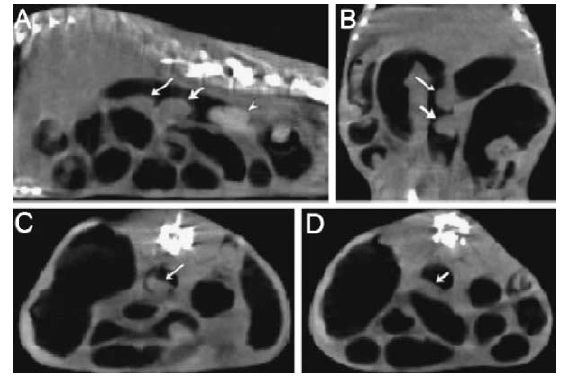
Fig. 1. Micro-CT colography prone images of an anaesthetised mouse in sagittal (A), coronal (B) and axial (C and D) positions. There are 2 colonic tumours (arrows) which were easily discrimi- nated from luminal faecal pellet (arrow head in A) [43].